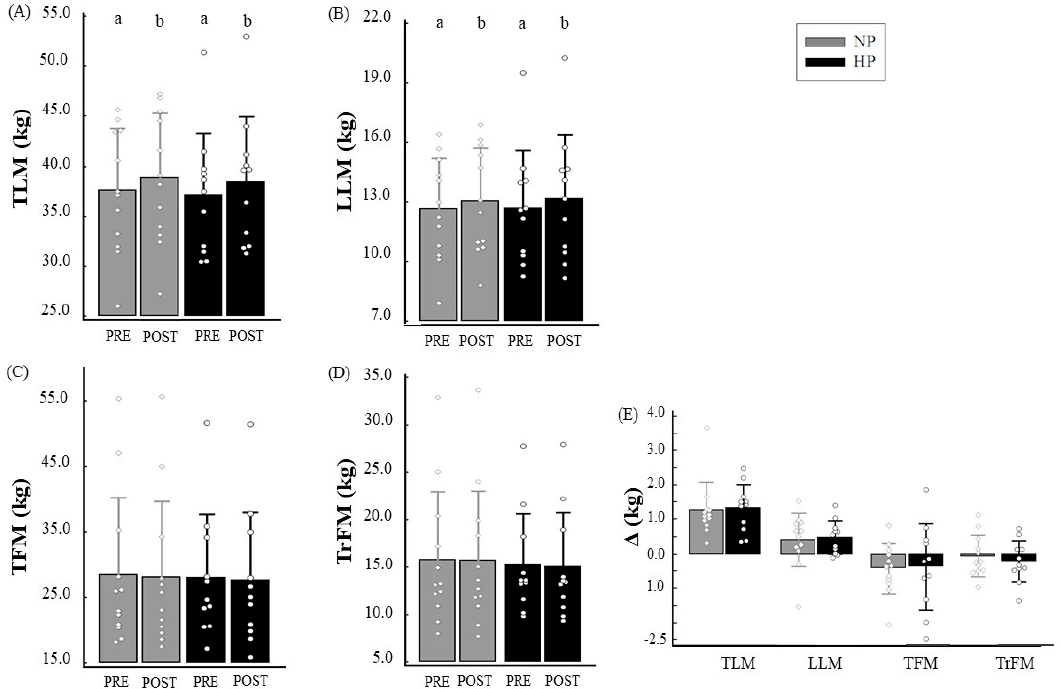
Figure 5. Total lean mass (TLM) ( A ), leg lean mass (LLM) ( B ), total fat mass (TFM) ( C ), and trunk fat mass (TrFM) ( D ) according to time and groups, and their respective deltas ( E ). Notes: ∆ : delta values; Generalized Estimating Equation (GEE) with sequential Sidak post hoc was performed to evaluate the intake between the groups and during the study; independent t -test was performed to evaluate the difference between deltas. Different letters (a, b) mean p <